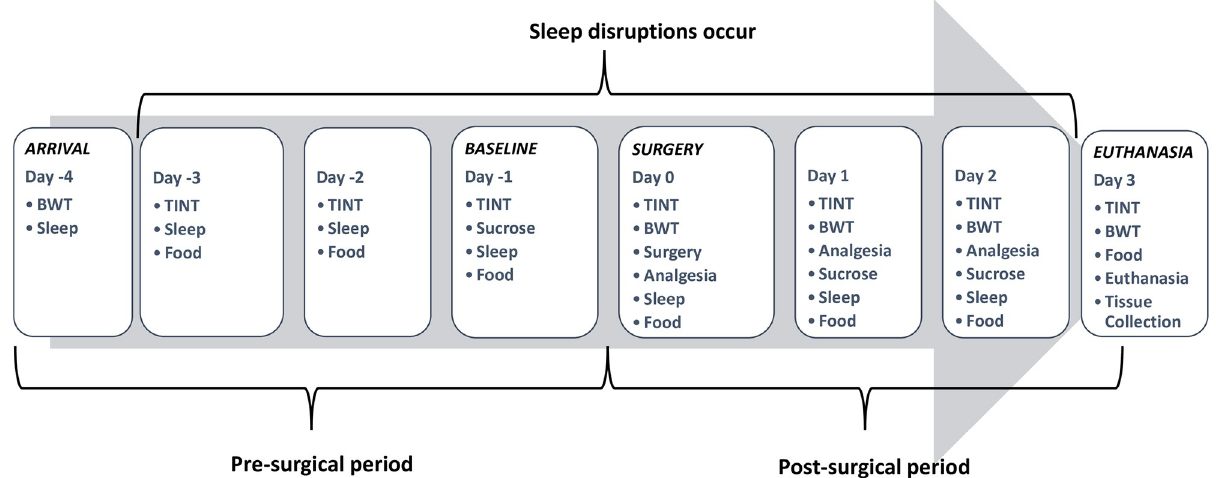
Fig 2. Experimental timeline. Lists all measurements made on each day of experiment. Day -1 is considered baseline. Mice arrive on Day -4. Abbreviations: BWT —bodyweight; Sleep —sleep monitoring; TINT —Time to Integrate Nesting Material Test; Food —food consumption; Sucrose — sucrose consumption; Analgesia —analgesia